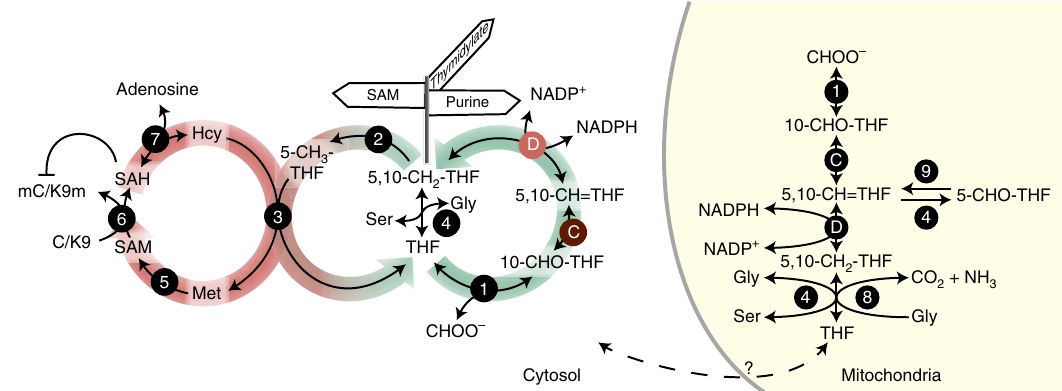
Figure 5 | Schematic representation of plant SAM and folate metabolism in the cytosol and mitochondria. One-carbon enters the cytoplasmic folate cycle (green) either through formyltetrahyrofolate synthetase (1) or SHMT (4); MTHFD1 reversibly interconverts 10-CHO-THF to 5,10-CH2-THF by cyclohydrolase (C) and NADP þ -dependent dehydrogenase (D) activity. 5,10-CH2-THF serves for thymidylate synthesis or is converted by methylenetetrahyrofolate reductase (2) to 5-CH3-THF, which enters the Met cycle (red) and serves for Hcy remethylation to Met by methionine synthase (3) (ref. 17). SAM synthetase (5) converts Met to SAM, which is further converted to SAH (6) during methylation of cytosines, H3K9 and so on. SAH is a competitive inhibitor of methyltransferases (6) and is recycled to Hcy by SAH hydrolase (7) (ref. 23). In mitochondria, one-carbon is transferred to THF during the oxidation of Gly by the glycine decarboxylase complex (8), but surplus of Gly due to photorespiration leads to consumption of one-carbon by SHMT during serine production 30 . 5-CHO-THF, a byproduct of SHMT, is metabolized by mitochondrial 5-formyltetrahyrofolate cycloligase in order to re-enter the folate cycle (9) (ref. 59). Shuttle of THF between mitochondria and the cytosol has been described in other organisms, but remains uncharacterized in plants.